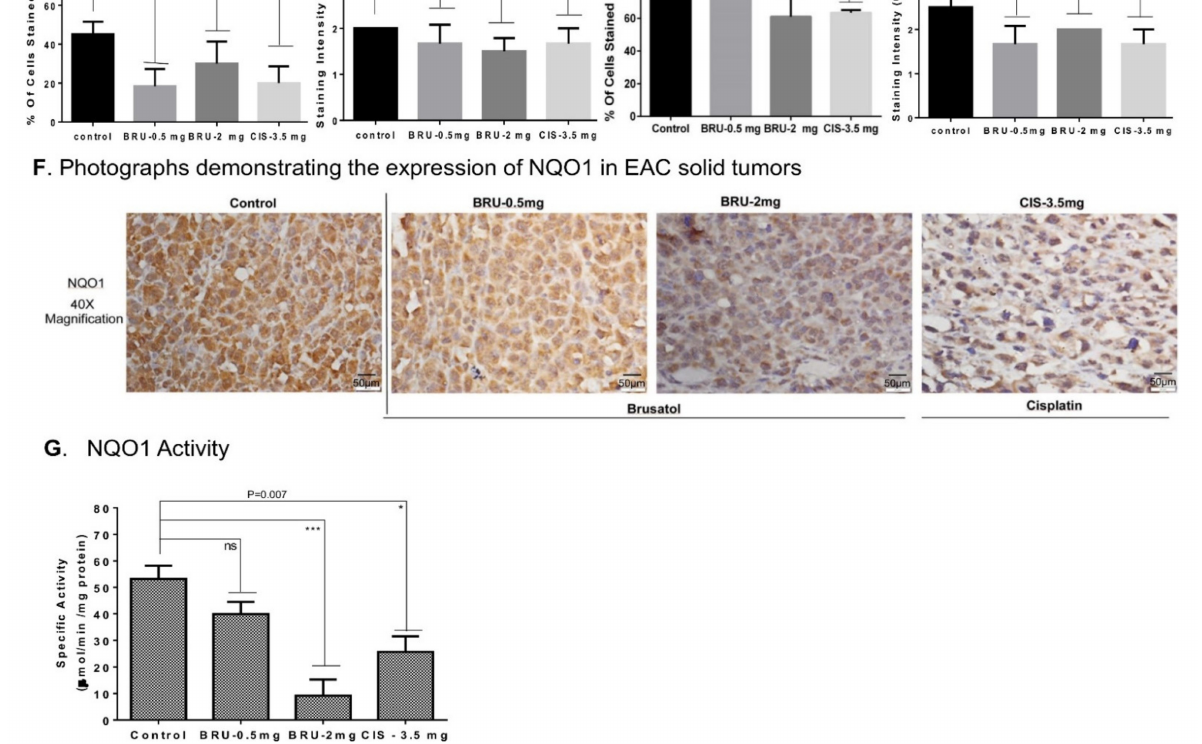
Figure 7. Effects of brusatol and cisplatin on Nrf2 and NQO1 expression and activity in EAC tumors ex vivo. ( A ) IHC staining analysis of Nrf2 expression and localization in engrafted EAC tumor tissues. Brusatol administration did not change the nuclear expression of Nrf2 (a; p value = 0.998; p value = 0.580). ( B ) Brusatol (0.5 mg/kg) induced a significant decrease in the number of cells with cytosolic Nrf2 expression (left panel; p value = 0.047). ( C ) Representative IHC